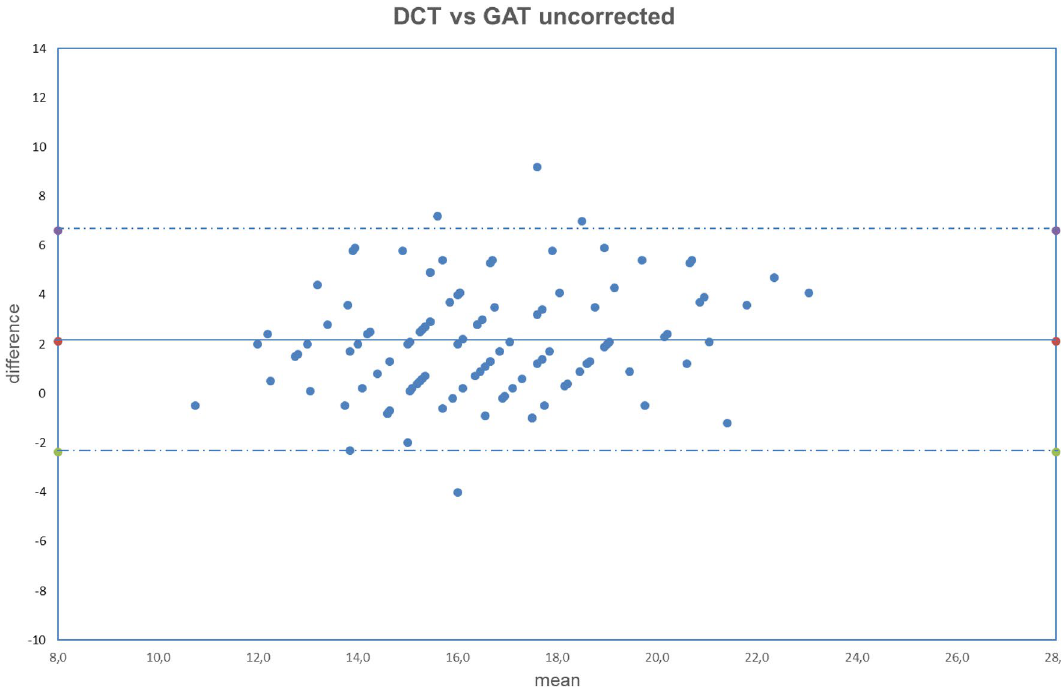
Figure 1. Bland–Altman plot between IOP measured with DCT and GAT uncorrected. Dashed line: mean difference. Dash-dotted lines: mean difference (2.11 mmHg) ± 2 standard deviation (2.24 mmHg) of the differences.